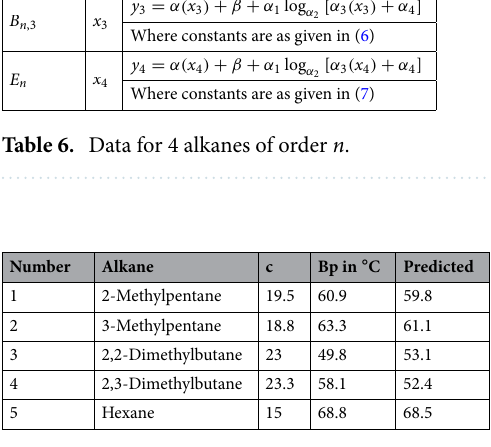
Table 7. All alkanes of order 6: Predictive ability of model (8).